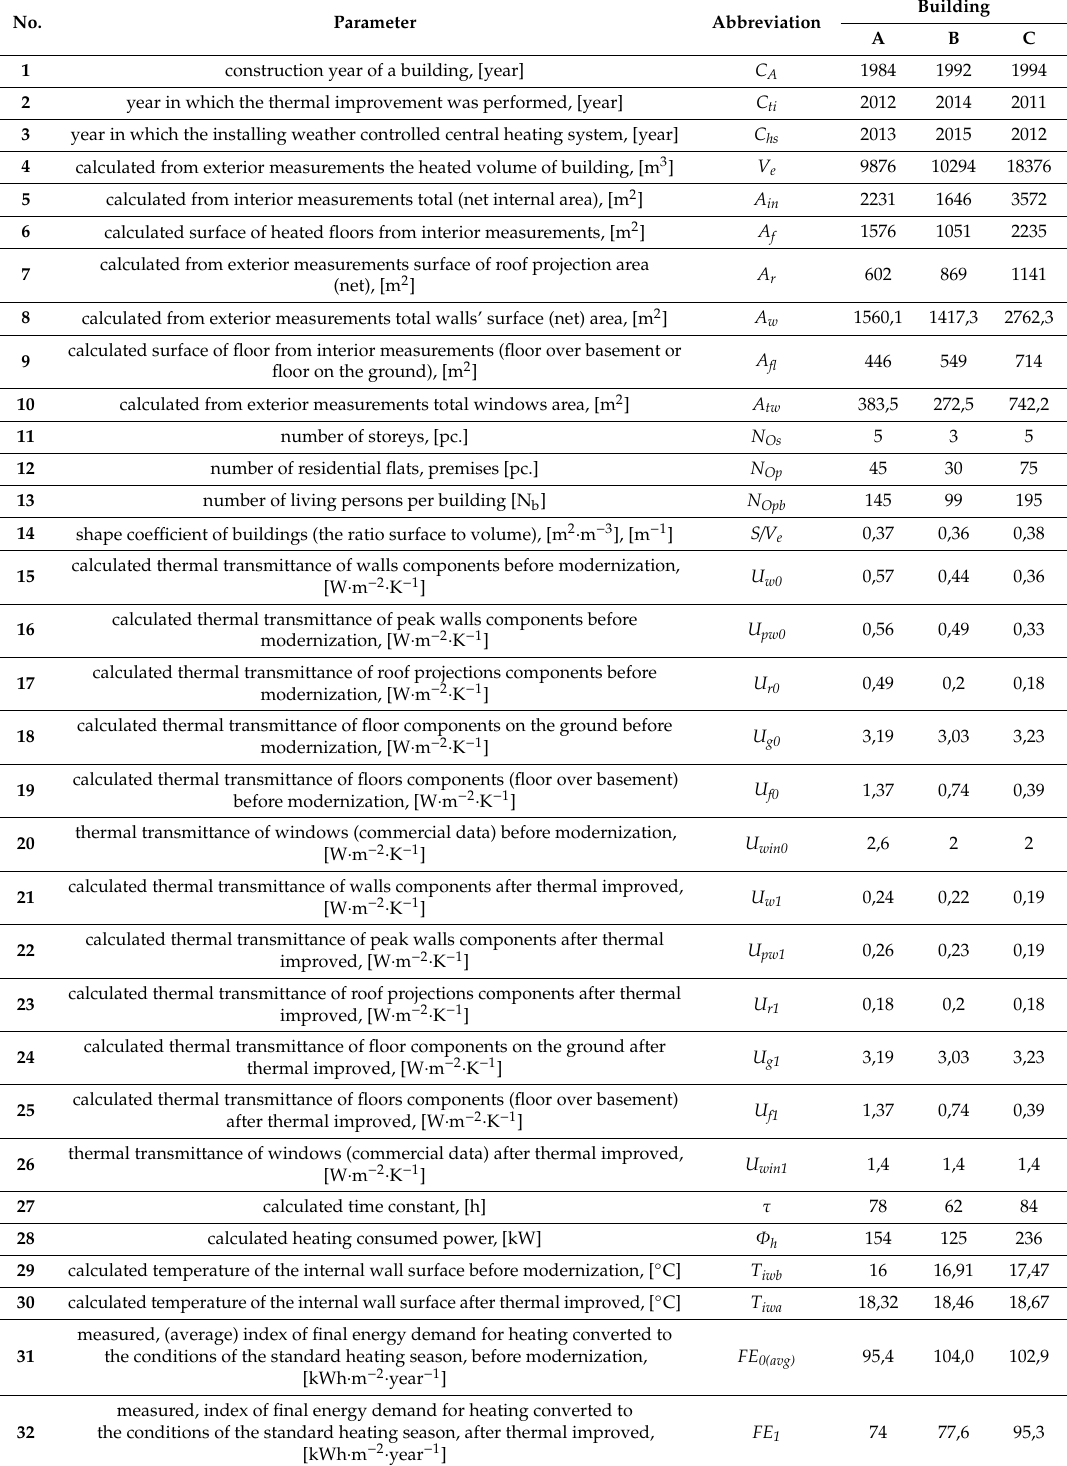
Table 4. Characteristics of variables influencing the energy needs of analyzed